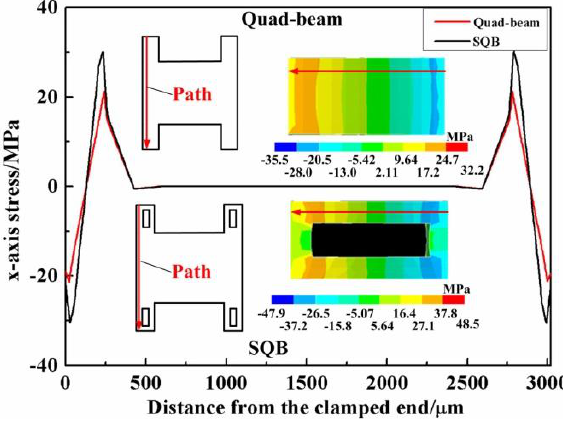
Figure 5. The x-axis stress distribution along the defined paths in two structures.